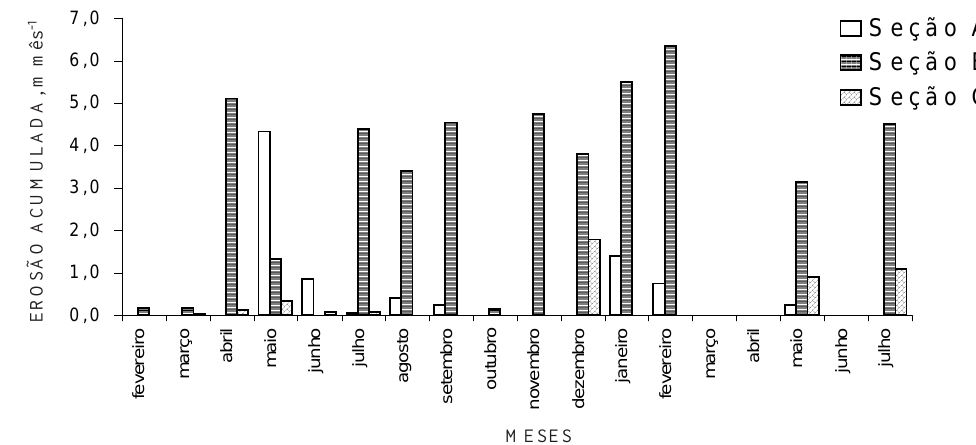
Figura 5. Taxas de erosão mensal nas seções